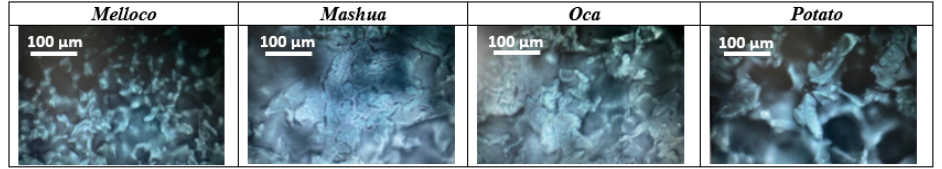
Figure 2. Micrographs of starch films extracted from each Andean tuber analyzed in reflection using white light transmission illumination.